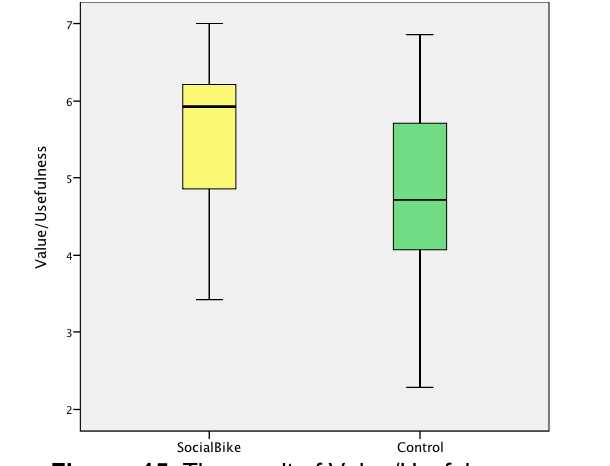
Figure. 15. The result of Value/Usefulness (ranges from